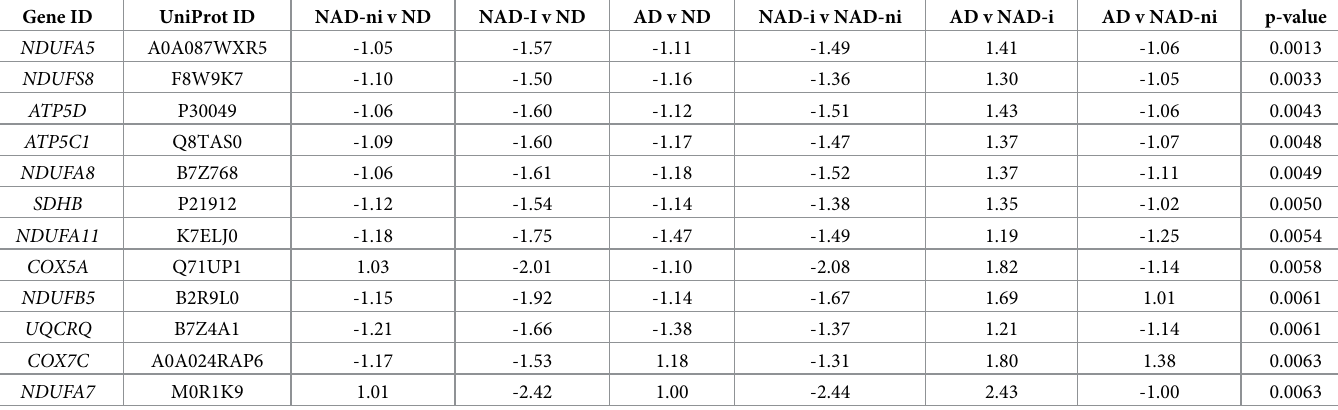
Table 2. Top 12 most significantly altered proteins in T2DM in EDM tissues associated with mitochondrial dysfunction.